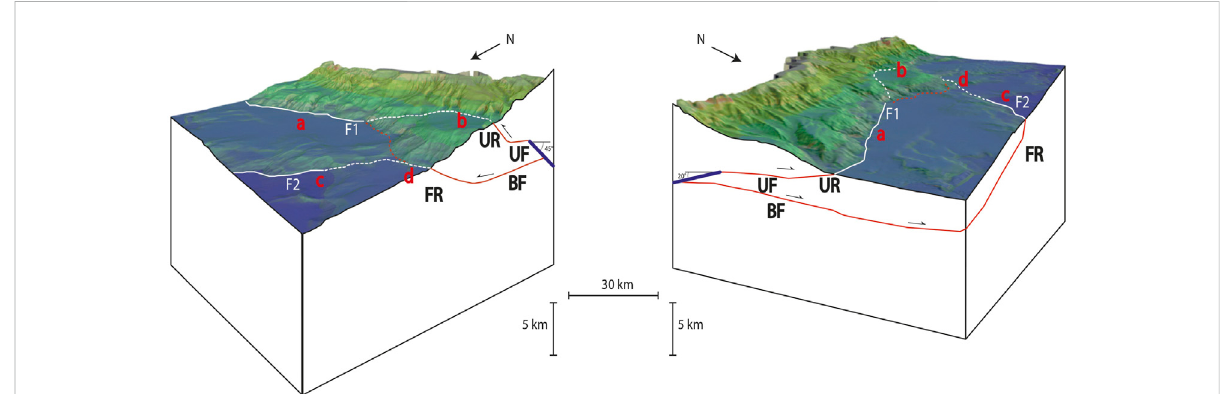
FIGURE 11 Perspective views of the tectonic fault system off Boumerdès using the Digital Elevation Model and summarizing our interpretation. Left and right: block diagrams looking toward the SE and SW, respectively, seen from the two edges of the 2003 Mw 6.8 main rupture. Thick dark blue line displays the top of the 2003 main rupture plane (Delouis et al., 2004; Kherroubi et al., 2017). F1 and F2 (white lines) represent the sea fl oor expression of thrust fault ramps (UR for Upper Ramps and FR for Frontal Ramps, respectively). UF and BF are for Upper Flats and Basal Flats respectively. Note that F1 and F2 faults are segmented (continuous and dashed lines for eastern and western segments respectively, labelled a, b, c, d, see Figure 10). Orange dashed line is an hypothetic surface expression of a transverse structure between F1 and F2